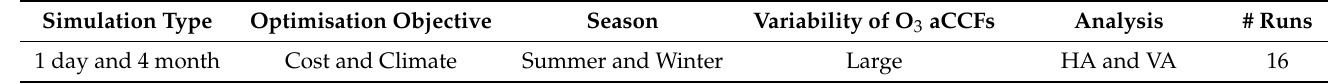
Table 3. Complete simulation setup.